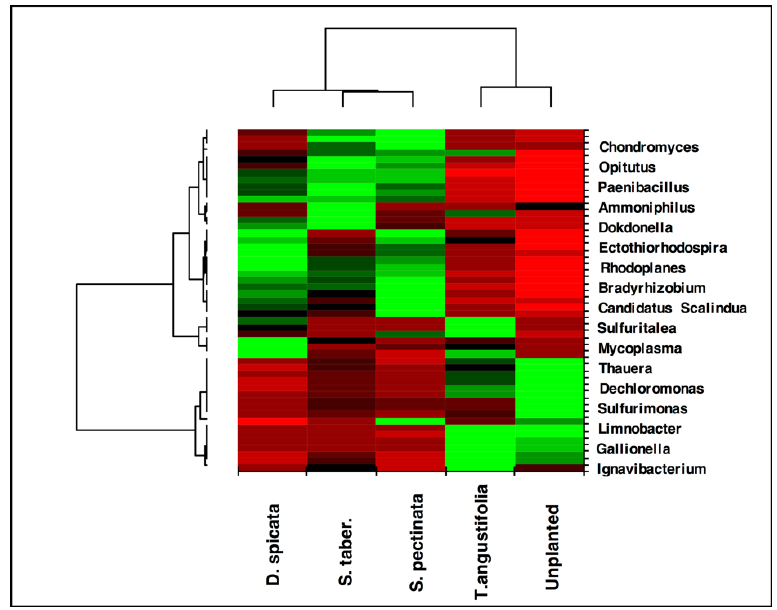
Figure 7. Heatmap and dendrogram of the biofilm from wood chips, based on the abundance of the microbial community at the genus level. Average ratios of 3 depths for each reactor and a nonspecific filtering for interquartile range < 0.25 were used. Only the main genera are shown for clarity and to illustrate the overall similarity between reactors.